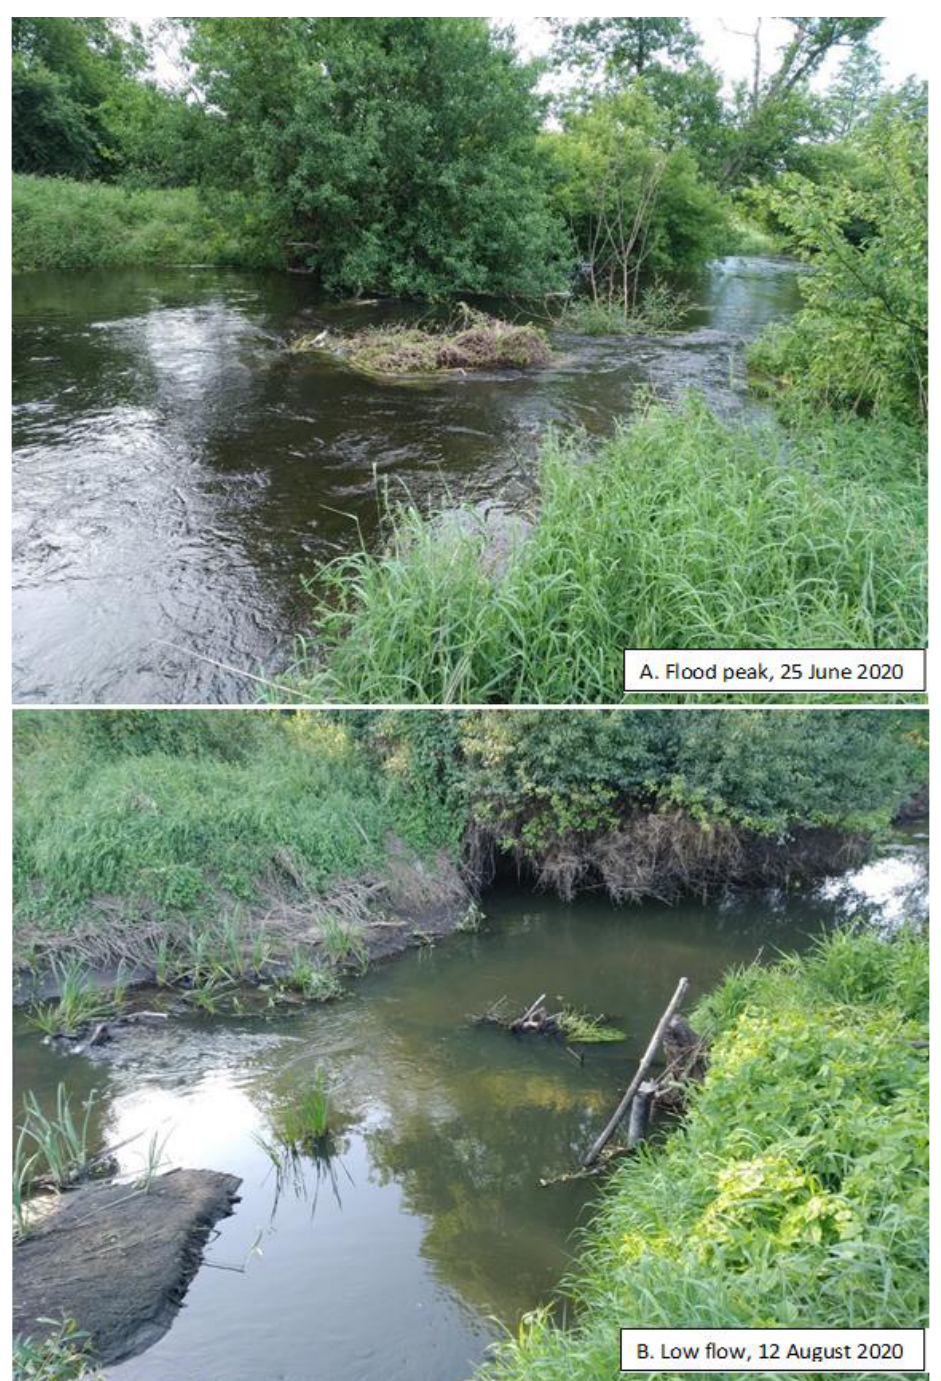
Figure 2. Pictures showing the measurement site M8 at the Jeziorka River ( A ) during the flood peak (25 June 2020) and ( B ) during the low-flow period (12 August 2020). The difference in meas- ured water levels between these dates was 1.8 m.